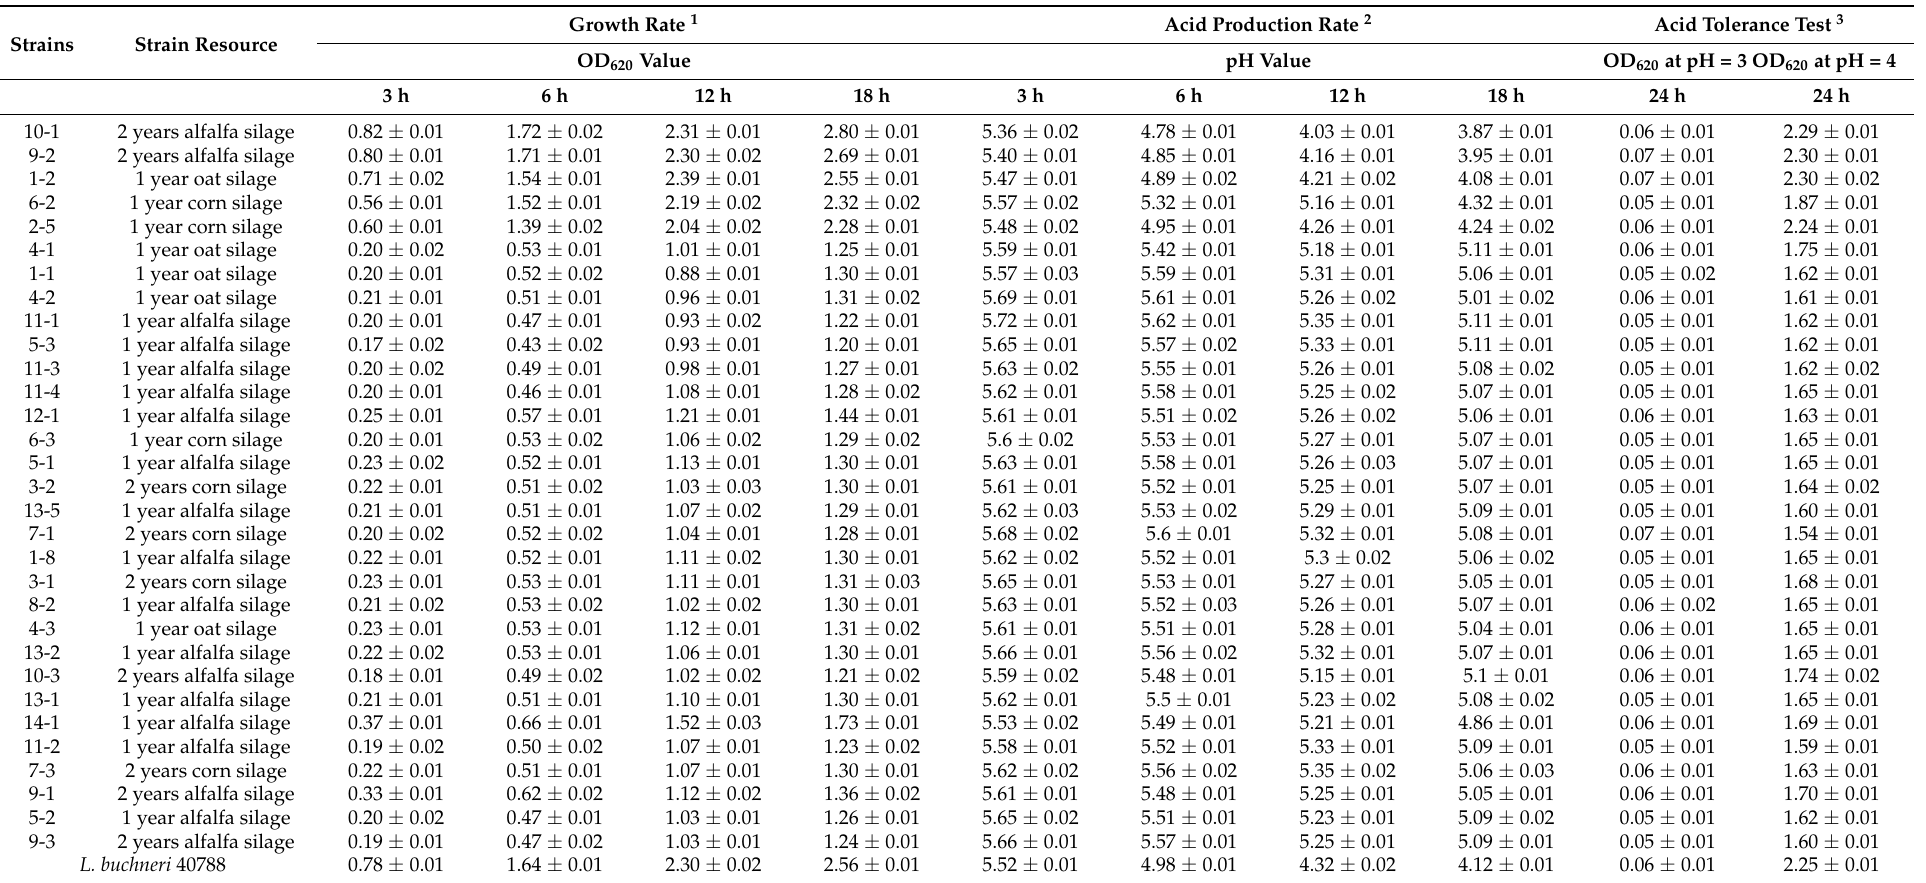
Table 1. Growth performance, acid production and acid tolerance of L. buchneri isolates from different silages fermented for 1 or 2 years (mean ± standard deviation). Strains Strain